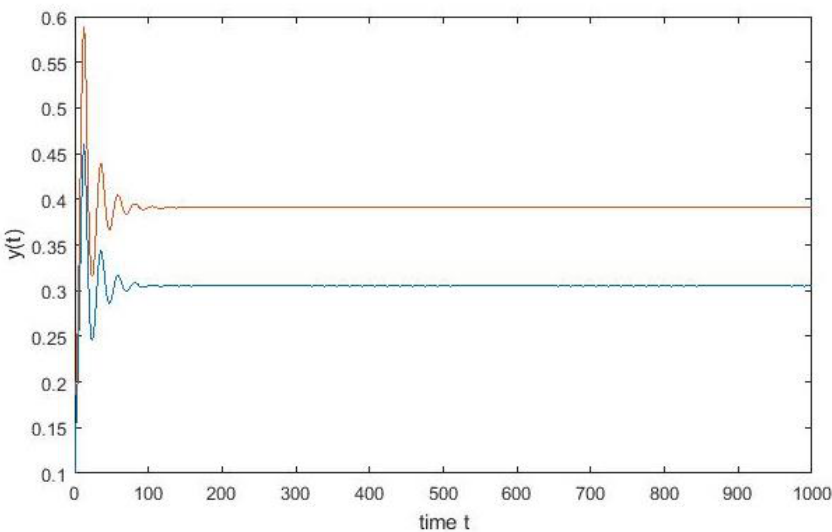
Figure 10. Tumour populations at interphase (blue line) and mitosis (red line) when τ = 0 at E 1 = ( 0.1,0.39,2.62,11.41 ) .